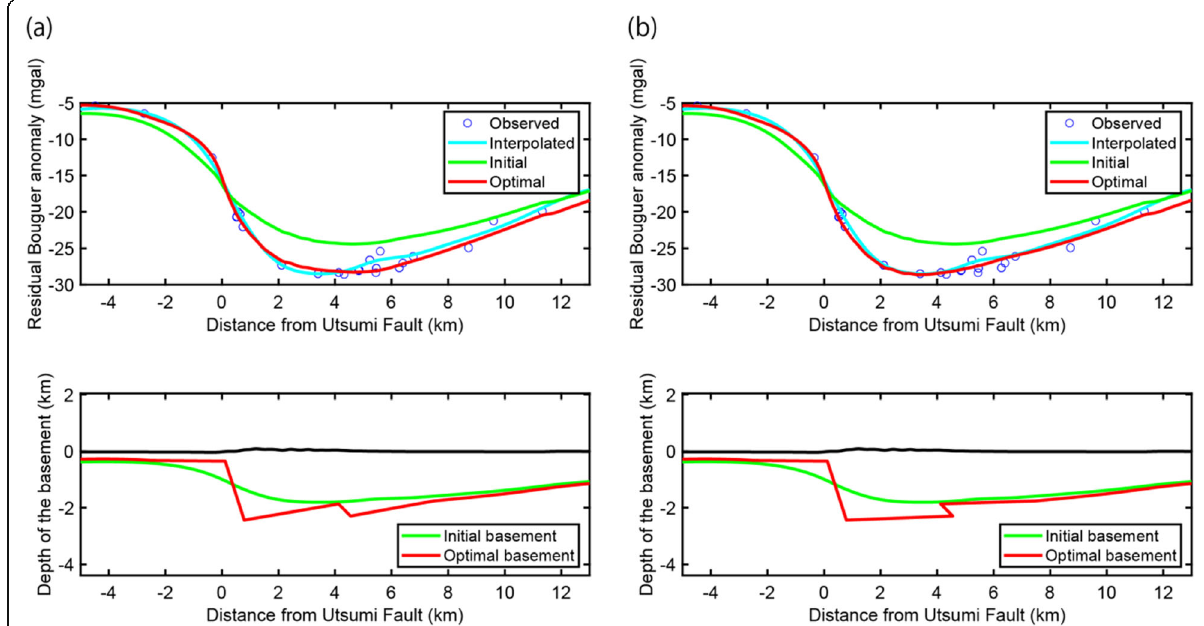
Fig. 10 Profiles of the Bouguer anomaly and the topography of the basement surface with 600 m of displacement along the Kou Fault at 2.26 km with a dip of 45° E. a Reverse fault structure of the Kou Fault using the optimal basement model. b Normal fault structure of the Kou Fault using the optimal basement model. Lines and circles are same as shown in Fig. 8. The origin of the x -axis is set at the tip of the Utsumi Fault in both a and b